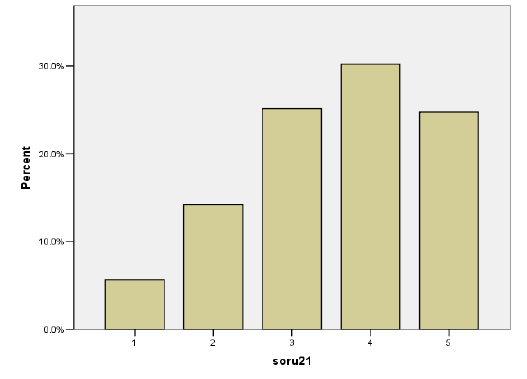
Figure 12. Should accounting education programs primarily focus on national and international exams organized for employment opportunities? Q23: Should accounting education give more importance to analysis and interpretation compared to recording and